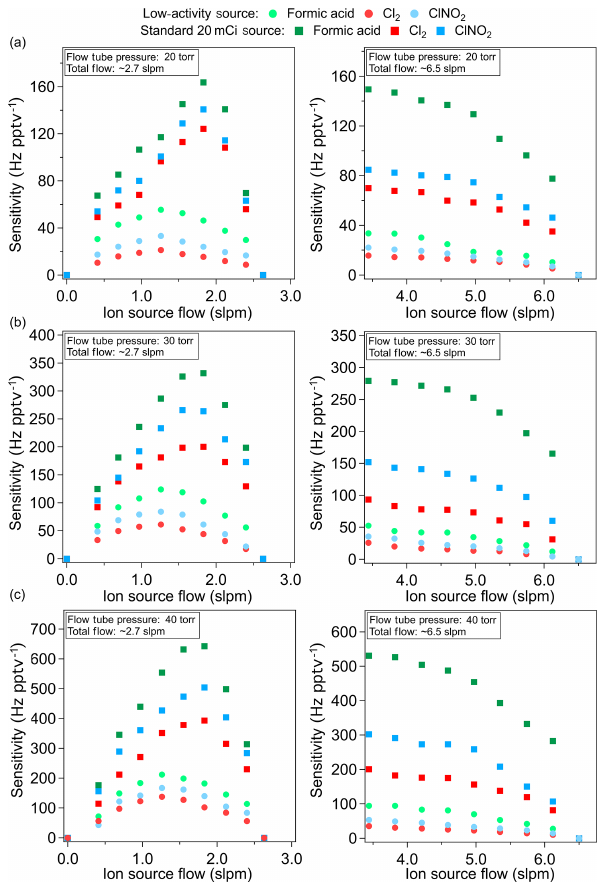
Figure 4. Comparison of the sensitivity (Hzpptv − 1 ) of the LAS and a standard source for formic acid ( m/z 179, green), Cl 2 ( m/z 197, red) and ClNO 2 ( m/z 208, cyan) plotted as a function of ion source flow (slpm). The age of the LAS and the standard source used here is approximately 2 and 4 months old, respectively. Panels (a) – (c) show the sensitivity at flow tube pressures of 20, 30 and 40torr at a total flow of 2.7slpm (left) and 6.5slpm